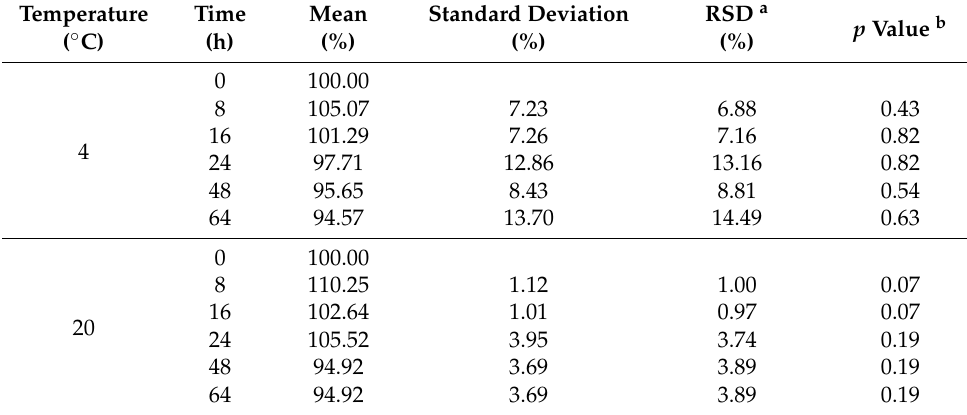
Table 1. Statistical analysis of stability test ( n = 3).